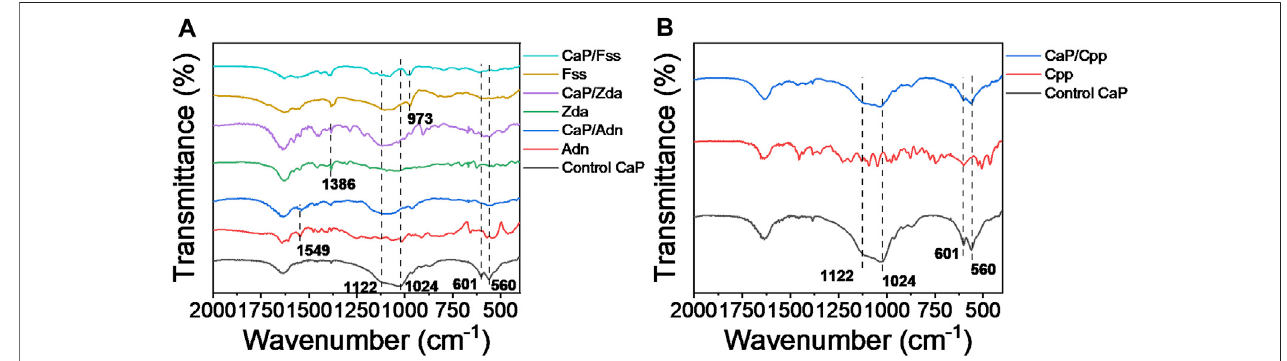
FIGURE 4 | FTIR spectra of (A) CaP Control, Adn, CaP/Adn, Zda, CaP/Zda, Fss, and CaP/Fss; (B) CaP Control, Cpp, and